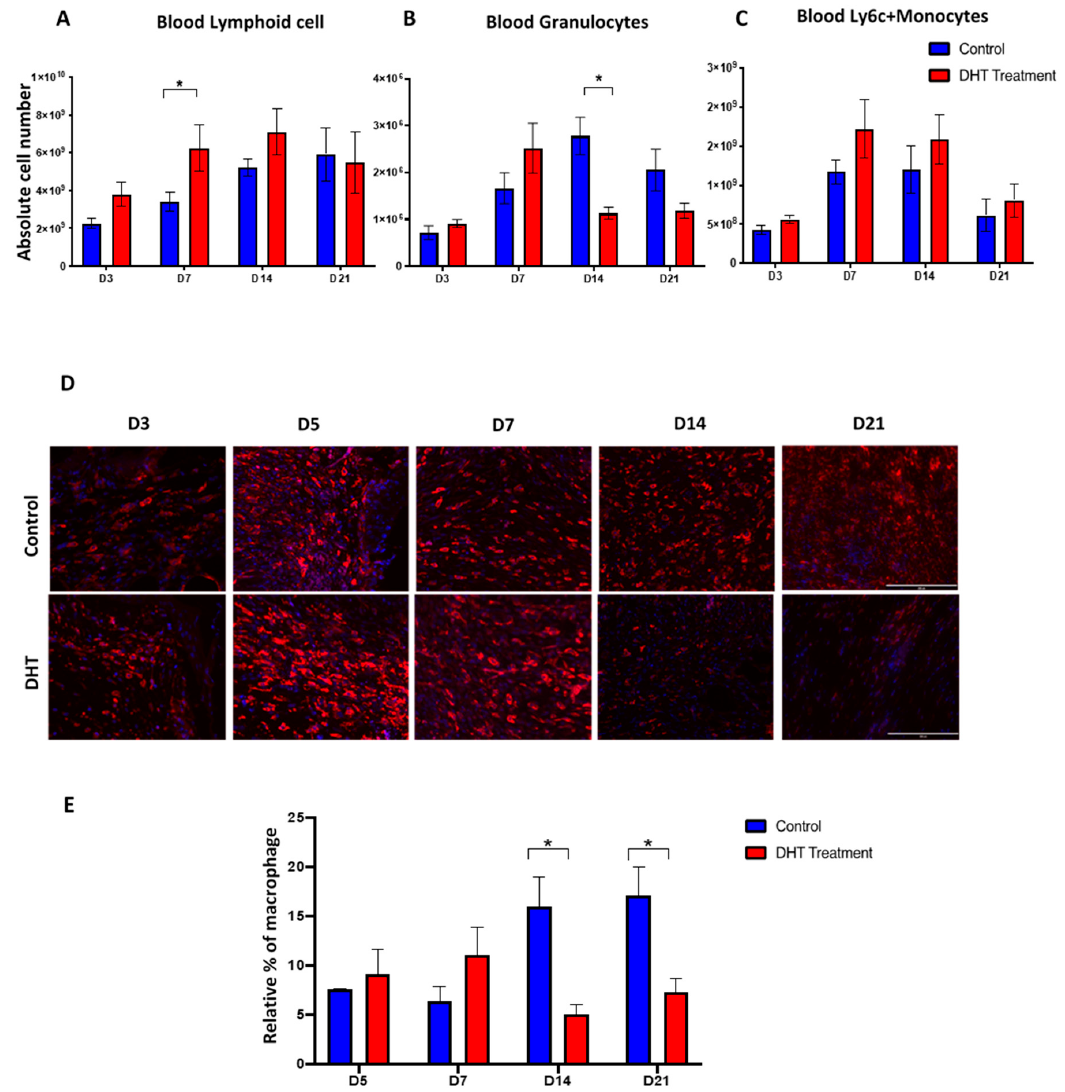
Figure 5. Blood immune populations and wound macrophage changes post-major burn injury. ( A – C ) Flow cytometry to identify the numbers of lymphoid cell, granulocytes and Ly6C + monocytes in the blood. n = 6 per timepoint. * p < 0.05 ( D ) Immunostaining of F4 / 80 labelled macrophage at the wound site. Early increase in F4 / 80 macrophage was observed in DHT treatment group at D5 and D7. ( E ) quantification of relative F4 / 80 macrophage percentages showing a late increase in F4 / 80 macrophage number in the control group. n = 4 per time point * p < 0.05